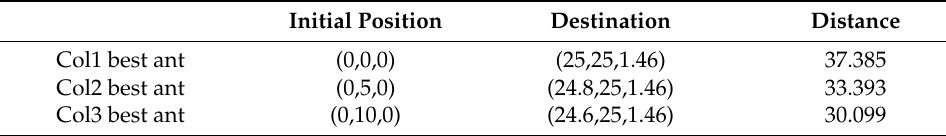
Table 4. Flight Details of Best Ants of Each Colony for Case II.